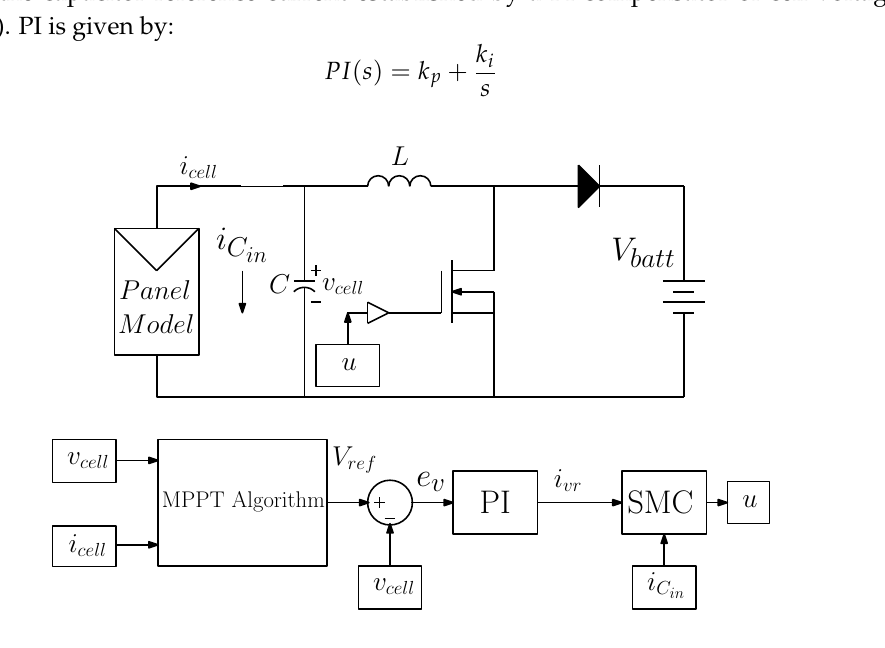
Figure 5. General Scheme of the MPPT